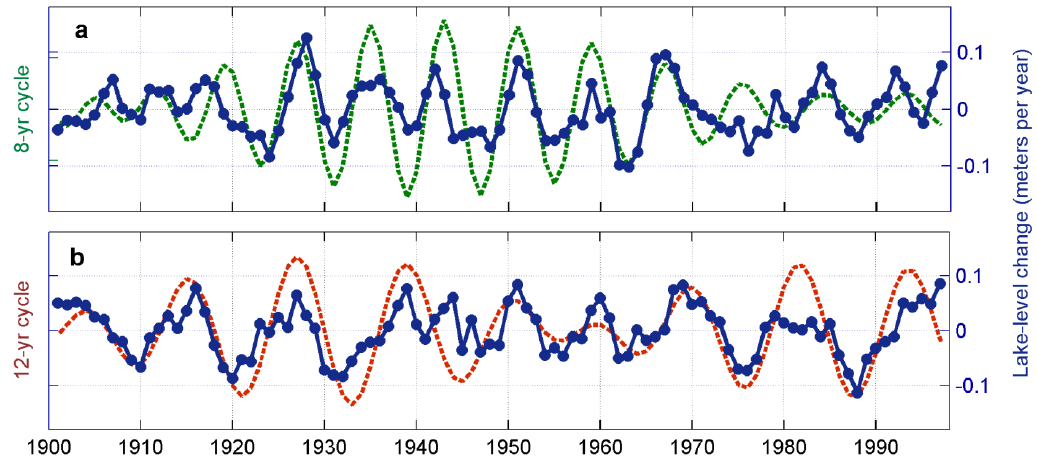
Figure 6. ( a ) Detrended wintertime (November–January) lake-level changes (cid:1856)(cid:1838) (cid:3052)(cid:3050) (blue) and the derivative of the 8-y lake-level reconstruction (cid:1856)(cid:1838) (cid:3052)(cid:3045)(cid:3030)(cid:2876) (green dashed); ( b ) Detrended summertime (June–August) lake-level changes (cid:1856)(cid:1838) (cid:3052)(cid:3046) (blue) and the derivative of the 12-y lake-level reconstruction (cid:1856)(cid:1838) (cid:3052)(cid:3045)(cid:3030)(cid:2869)(cid:2870) (red